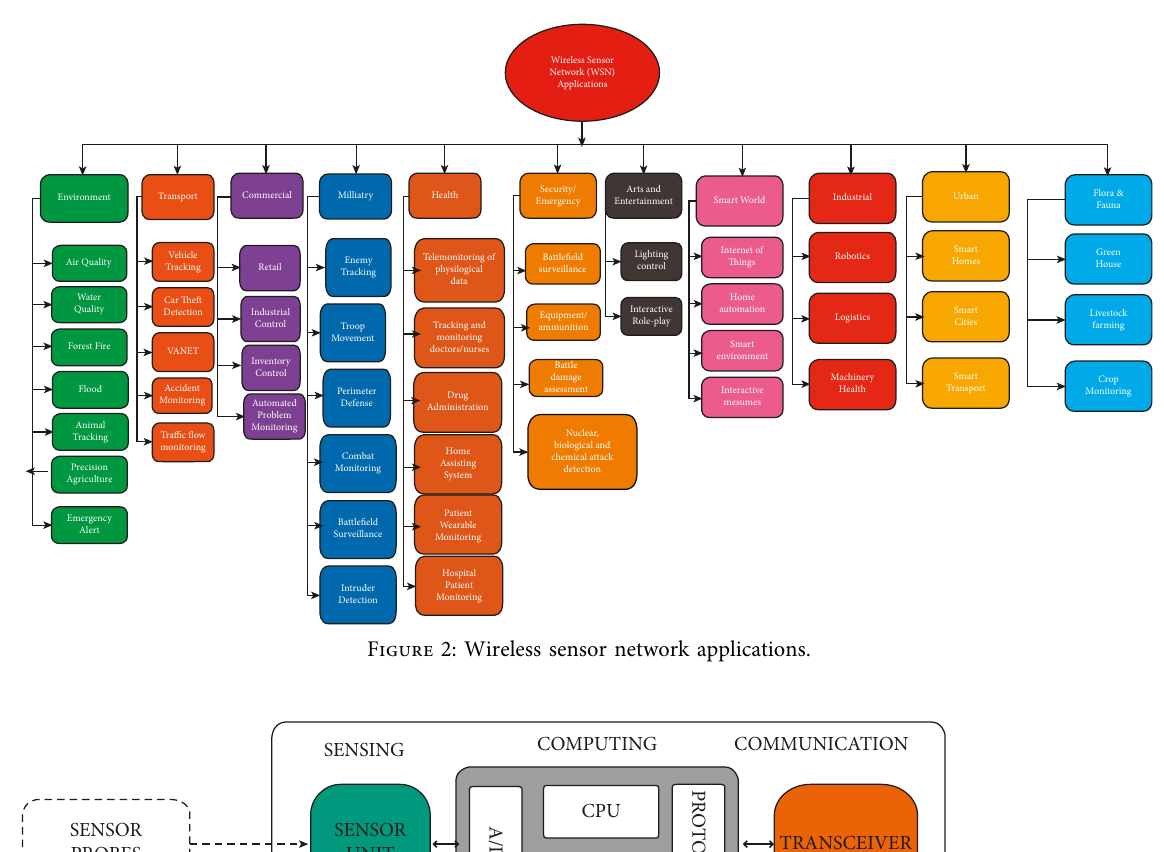
Figure 2: Wireless sensor network applications.